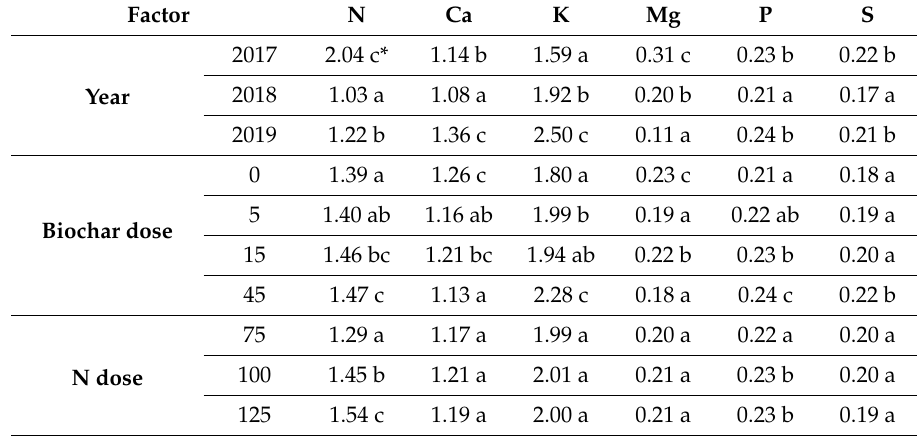
Table 6. Macronutrients (%DM) and sodium (mg kg − 1 DM) content in mint biomass depending on